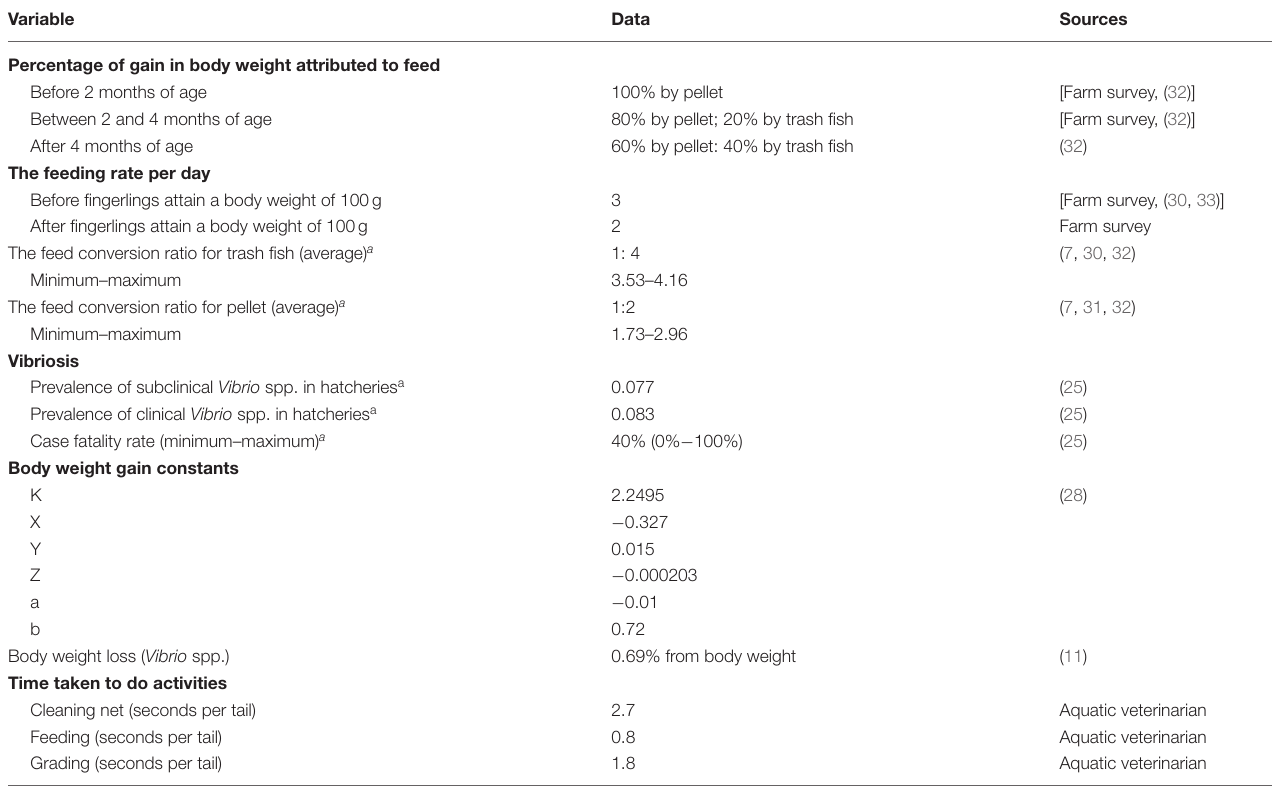
TABLE 4 | Other biological inputs used in the stochastic bioeconomic model for grow-out in Asian